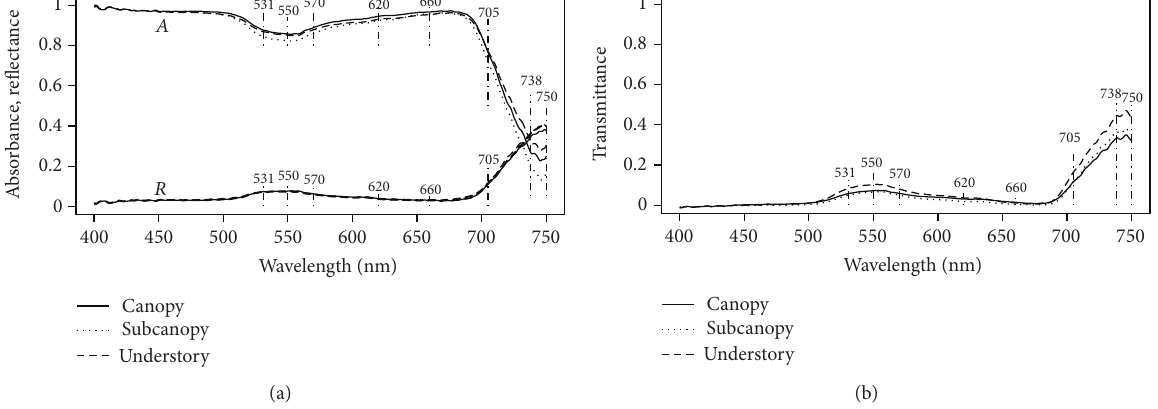
F 4: Spectra for each group (canopy, subcanopy, and understory) averaged across species. (a) Absorbance (